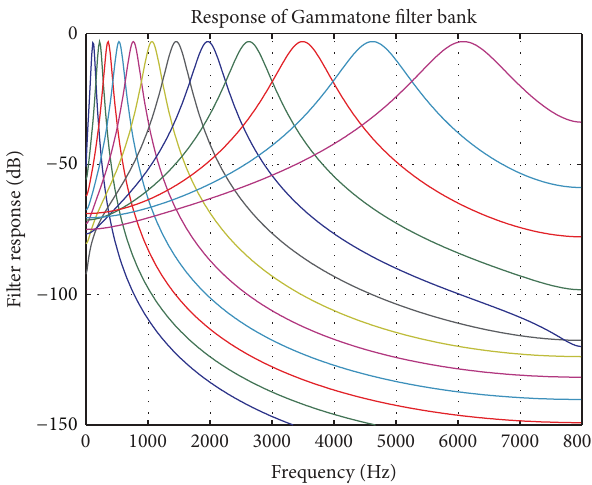
Figure 7: Gammatone filter bank with 25